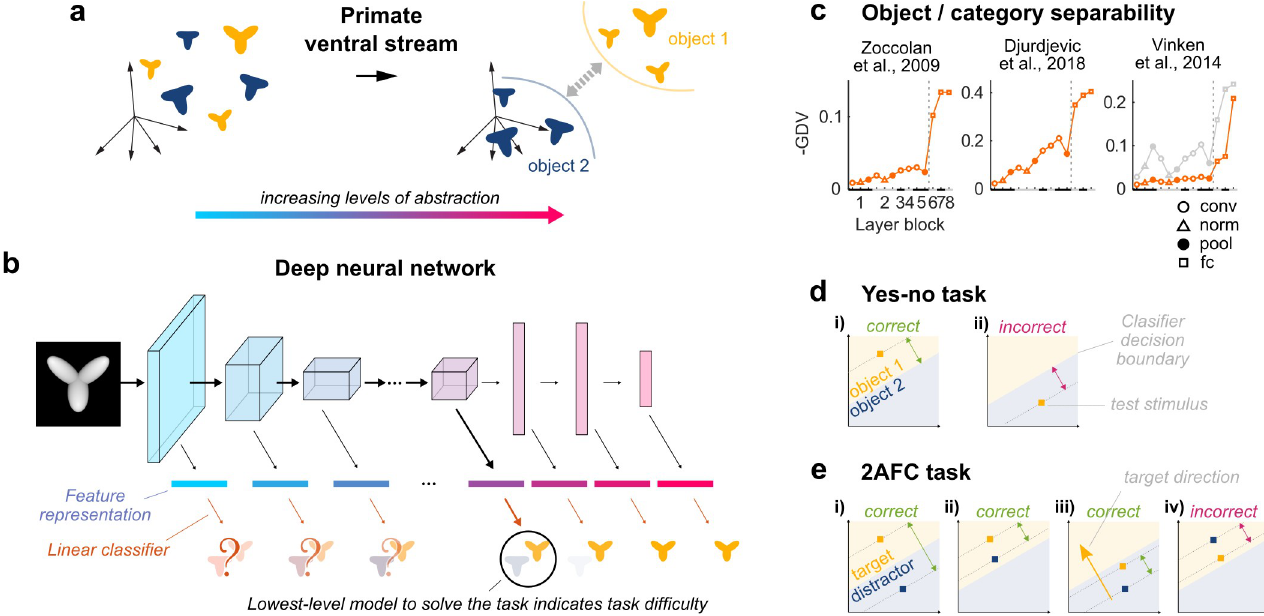
Fig 1. Evaluating visual object recognition tasks using DNN-based models. ( a ) The primate ventral stream is thought to transform visual representations where objects are entangled, into more abstract visual representations where objects are increasingly separable [12]. ( b ) A feedforward DNN trained in object categorization of natural images, separated in a sequence of models with increasingly higher-level representations, by training separate fully connected decoder layers (i.e., linear classifiers) on top of each DNN layer’s feature representation. ( c ) Higher-level DNN representations (AlexNet) show increased separability of visual stimuli according to object identity [for the stimuli of [1] (left) and of [5] (middle)] and category [for the stimuli of [6] (right; orange: natural distractors; grey: scrambled distractors)]. Separability was quantified as the sign-reversed Generalized Discrimination Value (GDV [13]), which is 0 for non-separable classes and 1 for perfectly separable classes. Black and grey bars on the X-axis indicate layer blocks and markers indicate layer types (see legend insert); the division between convolutional and fully connected layer blocks is indicated by a dashed line. ( d ) For yes-no tasks, correct or incorrect classification of a test stimulus (square marker) was evaluated by comparing the output label of the classifier with the true object label. ( e ) For 2AFC tasks, both the position of the target (yellow marker) and the distractor (blue marker) relative to the decision boundary were taken into account: for a correct response, the target stimulus needed to be positioned more towards the direction of the target side of the decision boundary (see yellow arrow in iii) than the distractor stimulus.